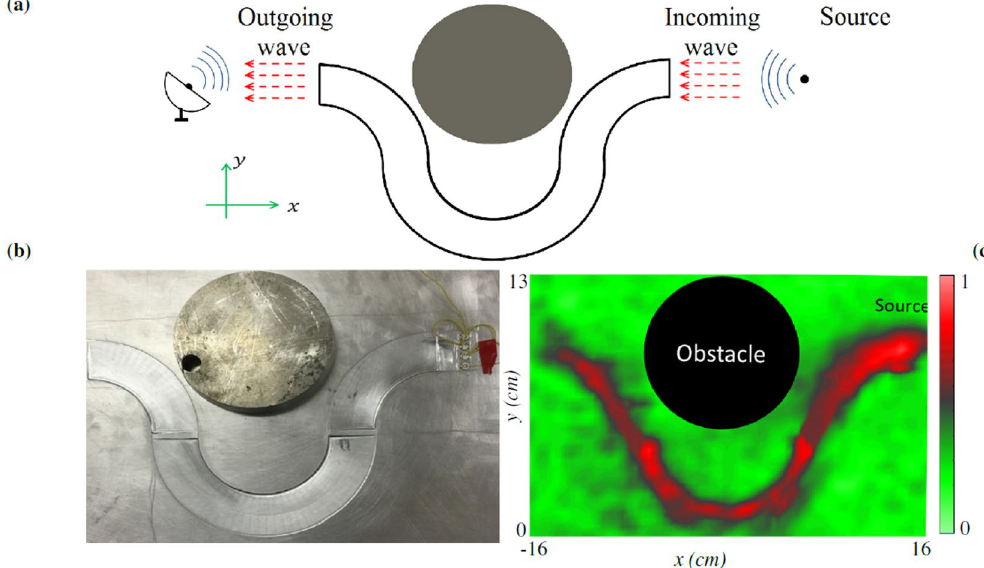
Figure 4. Experimentally measured wave circumventing around an obstacle. ( a ) Schematic of the proposed method to rotate the traveling wave around an obstacle, (b) experimental modeling, and (c) normalized RMS wavefield response of the system to a harmonic incoming plane wave at the frequency of 50 kHz